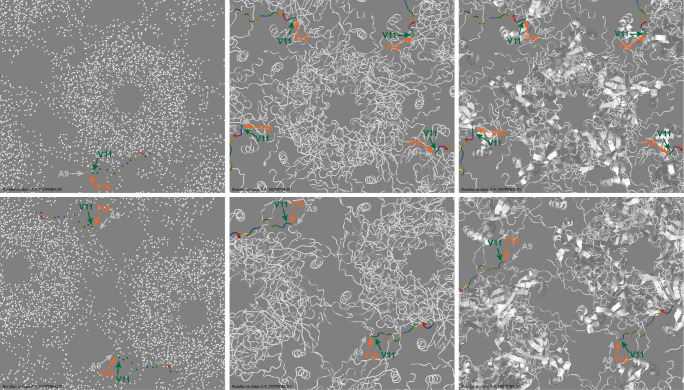
Pseudoatomic modeling of L1 proteins in the viral capsid.Model of HPV16 capsid (cryo-electron microscopy, structure ID: 3J6R, view from inside of the capsid, display: left: ball and stick, middle: trace, right: cartoon). The chain starts at residue 9. The first three residues ATV of the different L1 proteins are indicated.